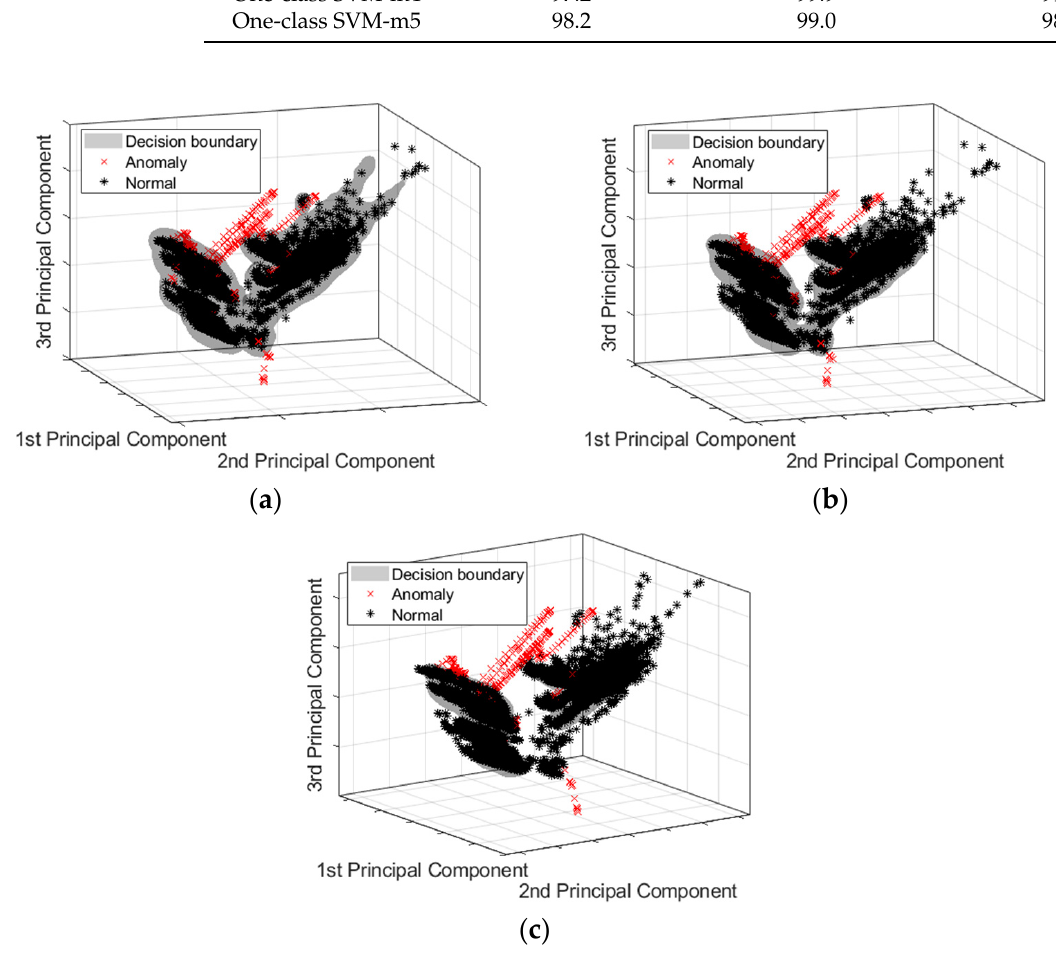
Figure 17. Decision boundaries of the one-class SVM-based anomaly detection models based on the outlier fraction: ( a ) outlier fraction = 0.01 [%]; ( b ) outlier fraction = 0.1 [%]; ( c ) outlier fraction = 1 [%] . Table 12. Test results of the one-class SVM-based anomaly detection models.